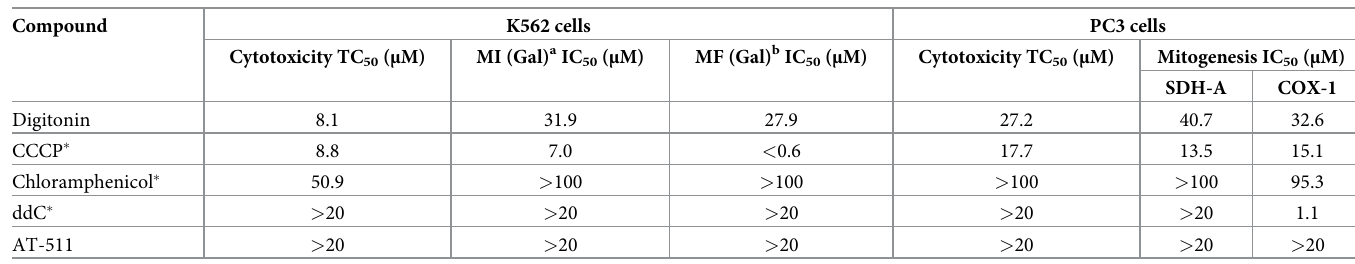
a Cell membrane integrity in glucose-free, galactose containing medium after 2 h incubation, as a measure of cell necrosis b Mitochondrial function in glucose-free, galactose containing medium after 2 h incubation, as measured by inhibition of cellular ATP levels